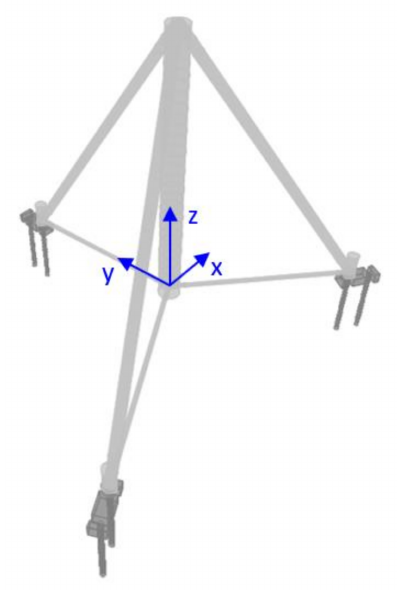
Figure 13. Numerical